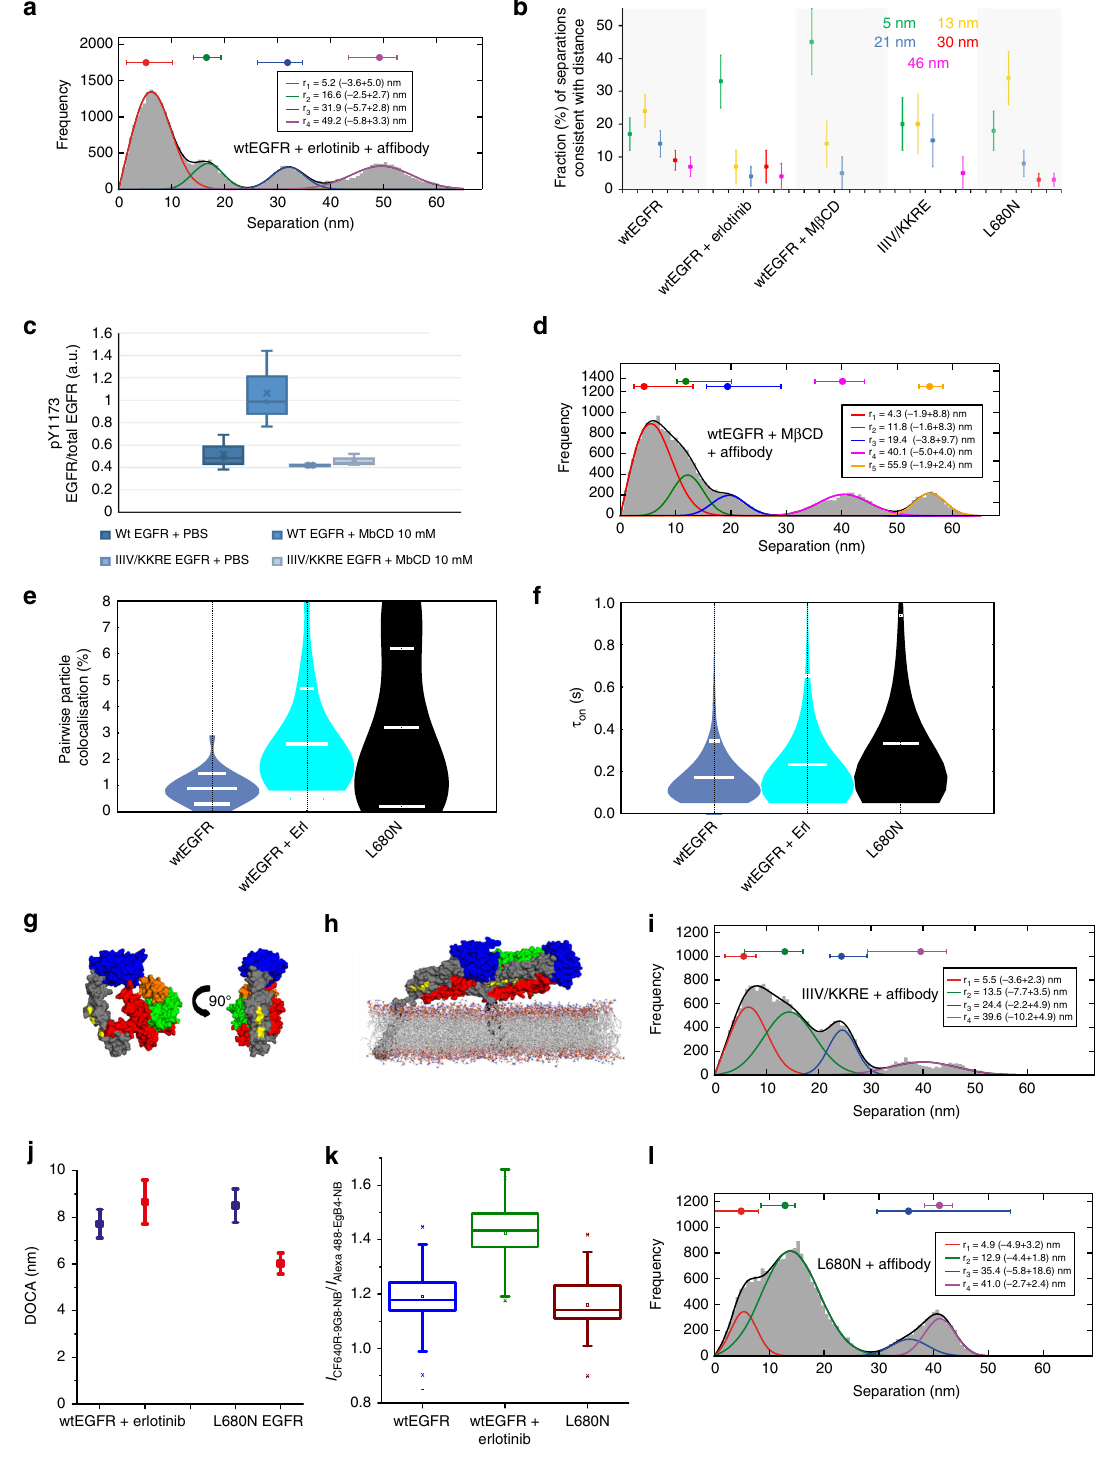
consistent with the requirement for DIV – DIV contacts for that of naked wtEGFR (Supplementary Fig. 10a, c, Supplementary stabilisation of a functional aTKD dimer (Fig. 5c). Table 4). To investigate conformational fl exibility, we compared We next used FRET to measure the separations from DI and the binding of 9G8-NB to erlotinib-bound wtEGFR and naked DIII to the membrane in erlotinib-bound wtEGFR. Assuming an wtEGFR. We found that 9G8-NB, which stabilises the tether 42 , displays greater binding to erlotinib-bound wtEGFR (Fig. 5k), upright orientation, the similar DI- and DIII-membrane separa- consistent with a greater ability to adopt a tethered conformation. tions found are consistent with a non-extended conformation, as This would be afforded by the increased fl exibility of the stalk-to- that predicted by the stalk-to-stalk dimer (Fig. 5j). In turn, error stalk dimer. analysis of the FRET data con fi rms a conformation different from NATURE COMMUNICATIONS| (2018) 9:4325 |DOI: